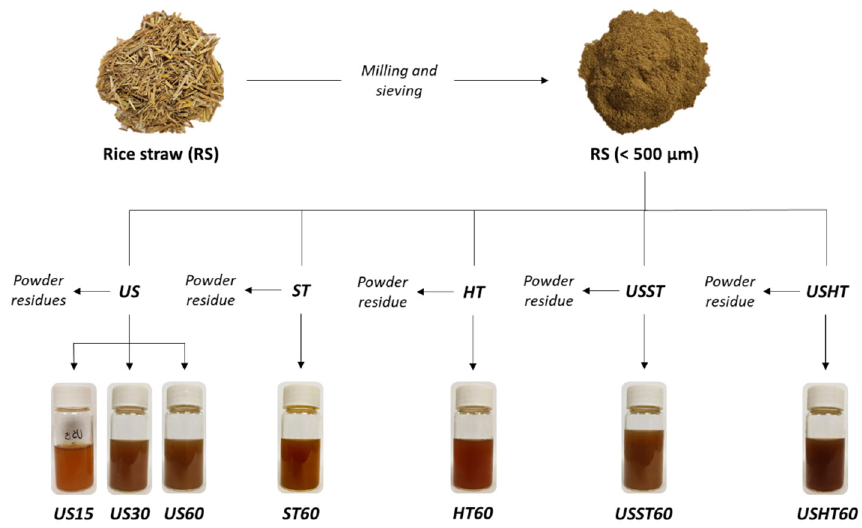
Figure 1. Schematic illustration and appearance of RS extracts obtained from di ff erent extraction processes: ultrasound (US), stirring (ST), heating under reflux condition (HT), and a combined treatment (USST and USHT). The number in the sample code indicates the processing time without considering the pre-treatment time.